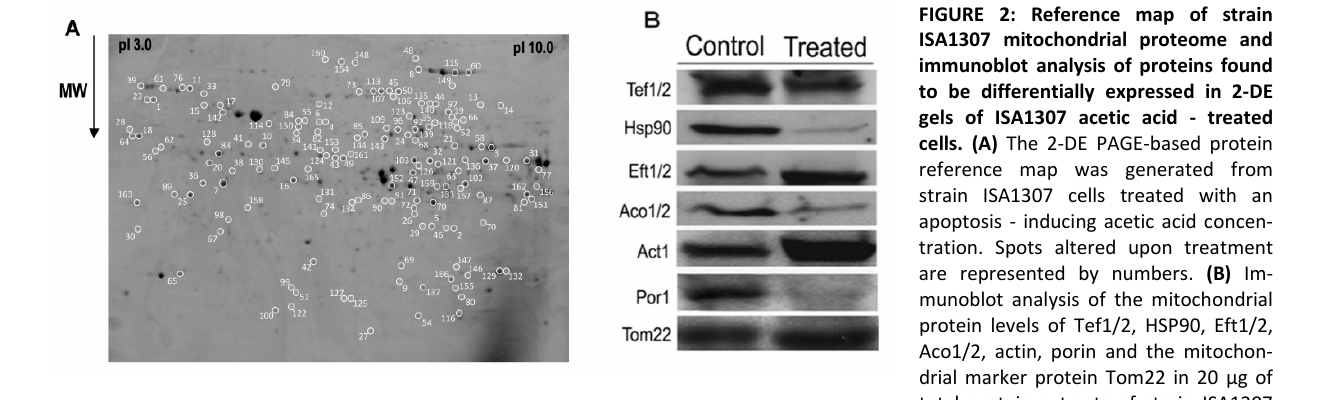
drial marker protein Tom22 in 20 µg of